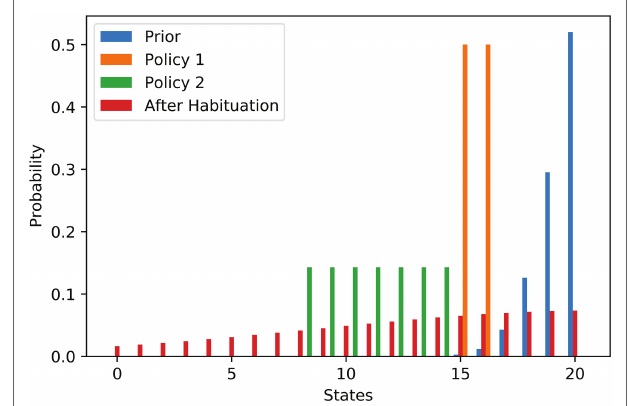
FIGURE 3 | Social acceptance scenario—flattening of probability distributions over goal states underlying stress habituation. The bars show the different probability distributions used in the example of social acceptance analogously to the example of work stimulus. Here, the most preferred situation is to have as much social acceptance as possible.